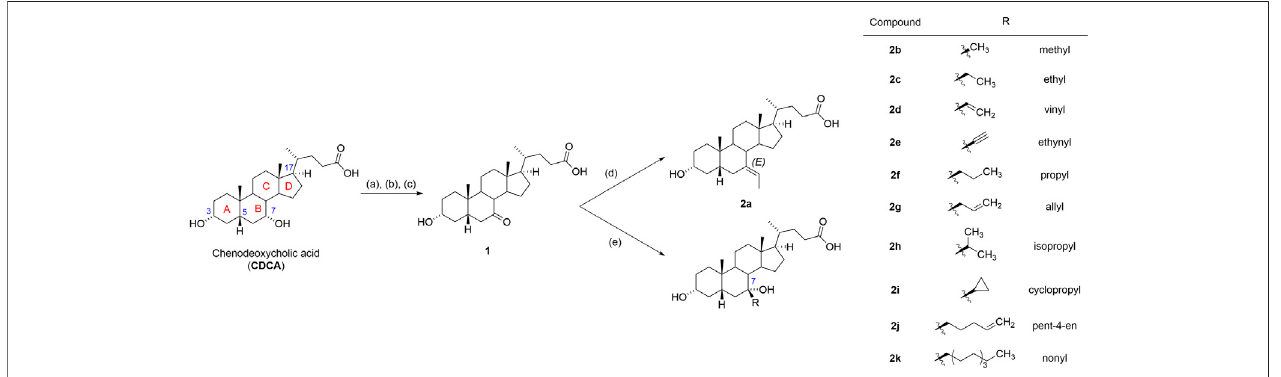
FIGURE 1 | Reagents and conditions. (A) H 2 SO 4 , MeOH, re fl ux; (B) CrO 3 , H 2 SO 4 , H 2 O, acetone, 0 ° C; (C) NaOH, MeOH, H 2 O, 50 ° C; (D) NaH, ethyltriphenylphosphonium bromide, THF, re fl ux, overnight; (E) RMgClfor 2f, 2h or RMgBr for 2b, 2c,2d, 2e, 2g, 2i, 2j, 2k,THF, re fl ux, 2 h. For CDCA, rings are lettered and steroid ring numbering at biologically signi fi cant positions and is